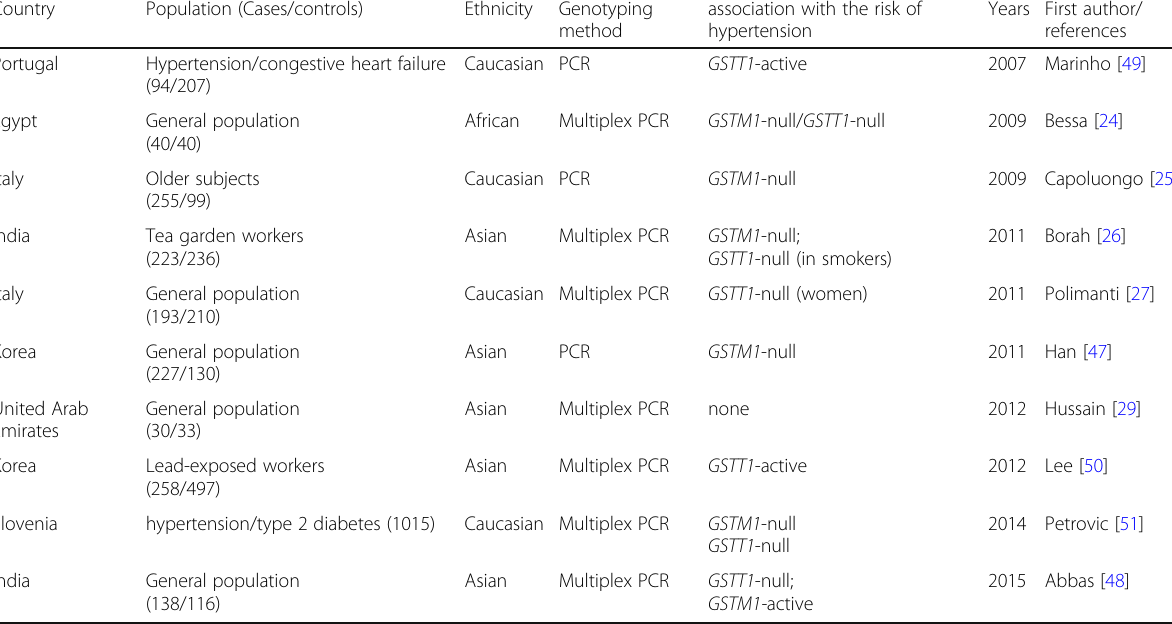
Table 5 Summary of previous studies examining GSTM1 and GSTT1 polymorphisms and hypertension risk Country Population (Cases/controls) Ethnicity Genotyping